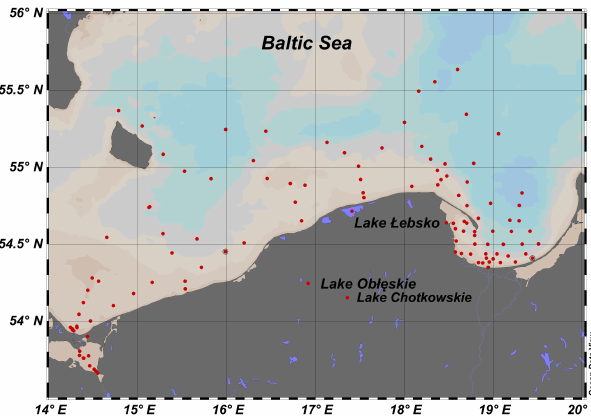
Figure 1. Positions of the measurement stations in